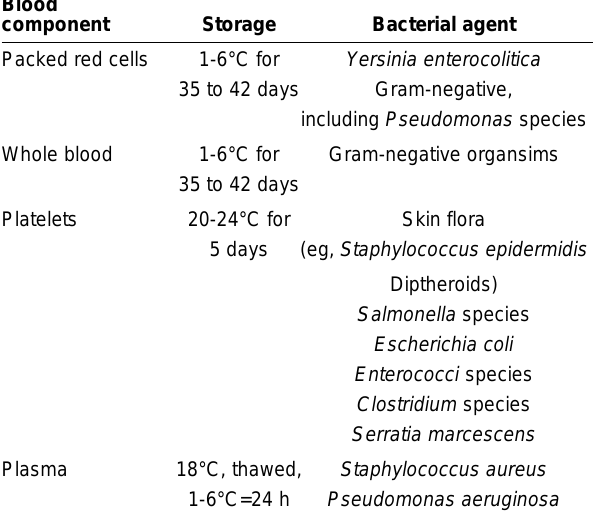
TABLE 2 Bacterial agents associated with acute infection during blood product